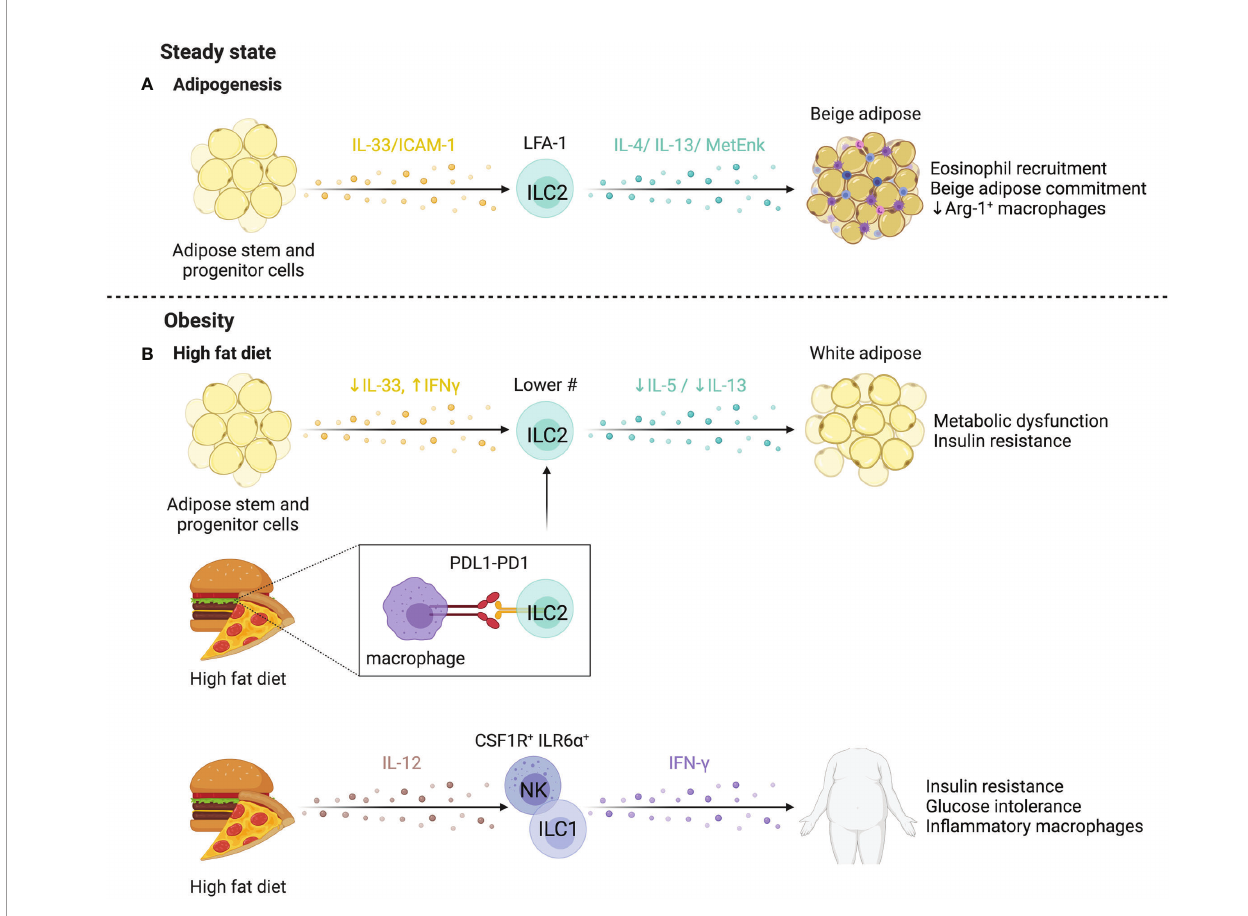
FIGURE 11 | ILCs in adipose tissue. (A) Using mostly mouse models, ILC2s are linked to adipogenesis, where they maintain homeostasis and prevent obesity by promoting adipose beiging. ILC2s are sustained by IL-33 from adipose stem and progenitor cells (ASPCs) and required stromal cell interactions via ICAM-1 and LFA-1. The resulting release of IL-4, IL-13 by ILC2s promotes eosinophil recruitment via stromal cell-derived eotaxin (CCL11). IL-33 stimulates ILC2-produced methionine- enkephalin (MetEnk), an endogenous opioid-like peptide that promotes adipose beiging. (B) Both obese humans and mice, have reduced ILC2s in the white adipose tissue due to diet-driven impairment of IL-33 production by ASPCs. The in fi ltration of IFN- g -producing ILCs actively represses cytokine release by ILC2s and propagates ILC2 inhibition through via PD-1 and macrophage-expressed PD-L1. A unique subpopulation of CSF1R + IL16R a + NK cells and increased ILC1 abundance positively correlates with glucose intolerance and insulin resistance. Overall, reduction of adipose ILC2s fosters metabolic dysfunction, insulin resistance and obesity. Created with